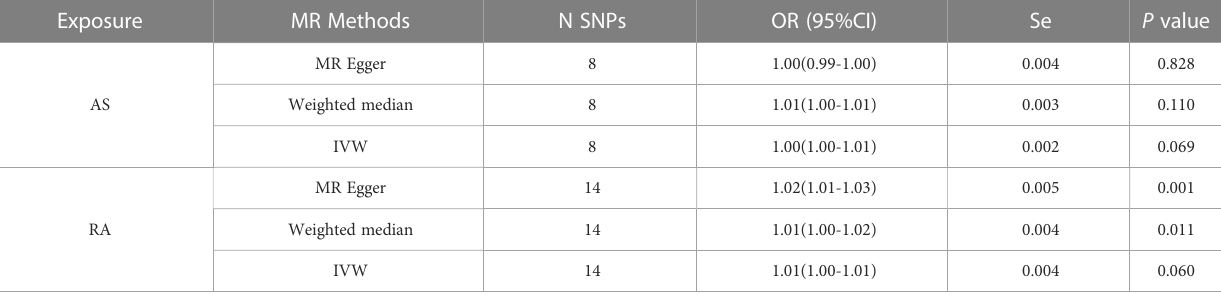
TABLE 3 MR Results of Ankylosing Spondylitis and Rheumatoid Arthritis Used on the Effect of LTL.